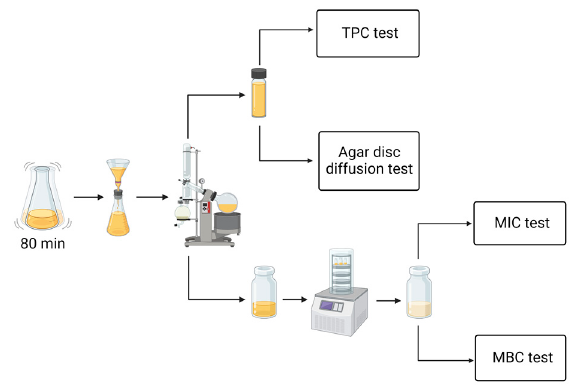
Figure 2. Extract preparation